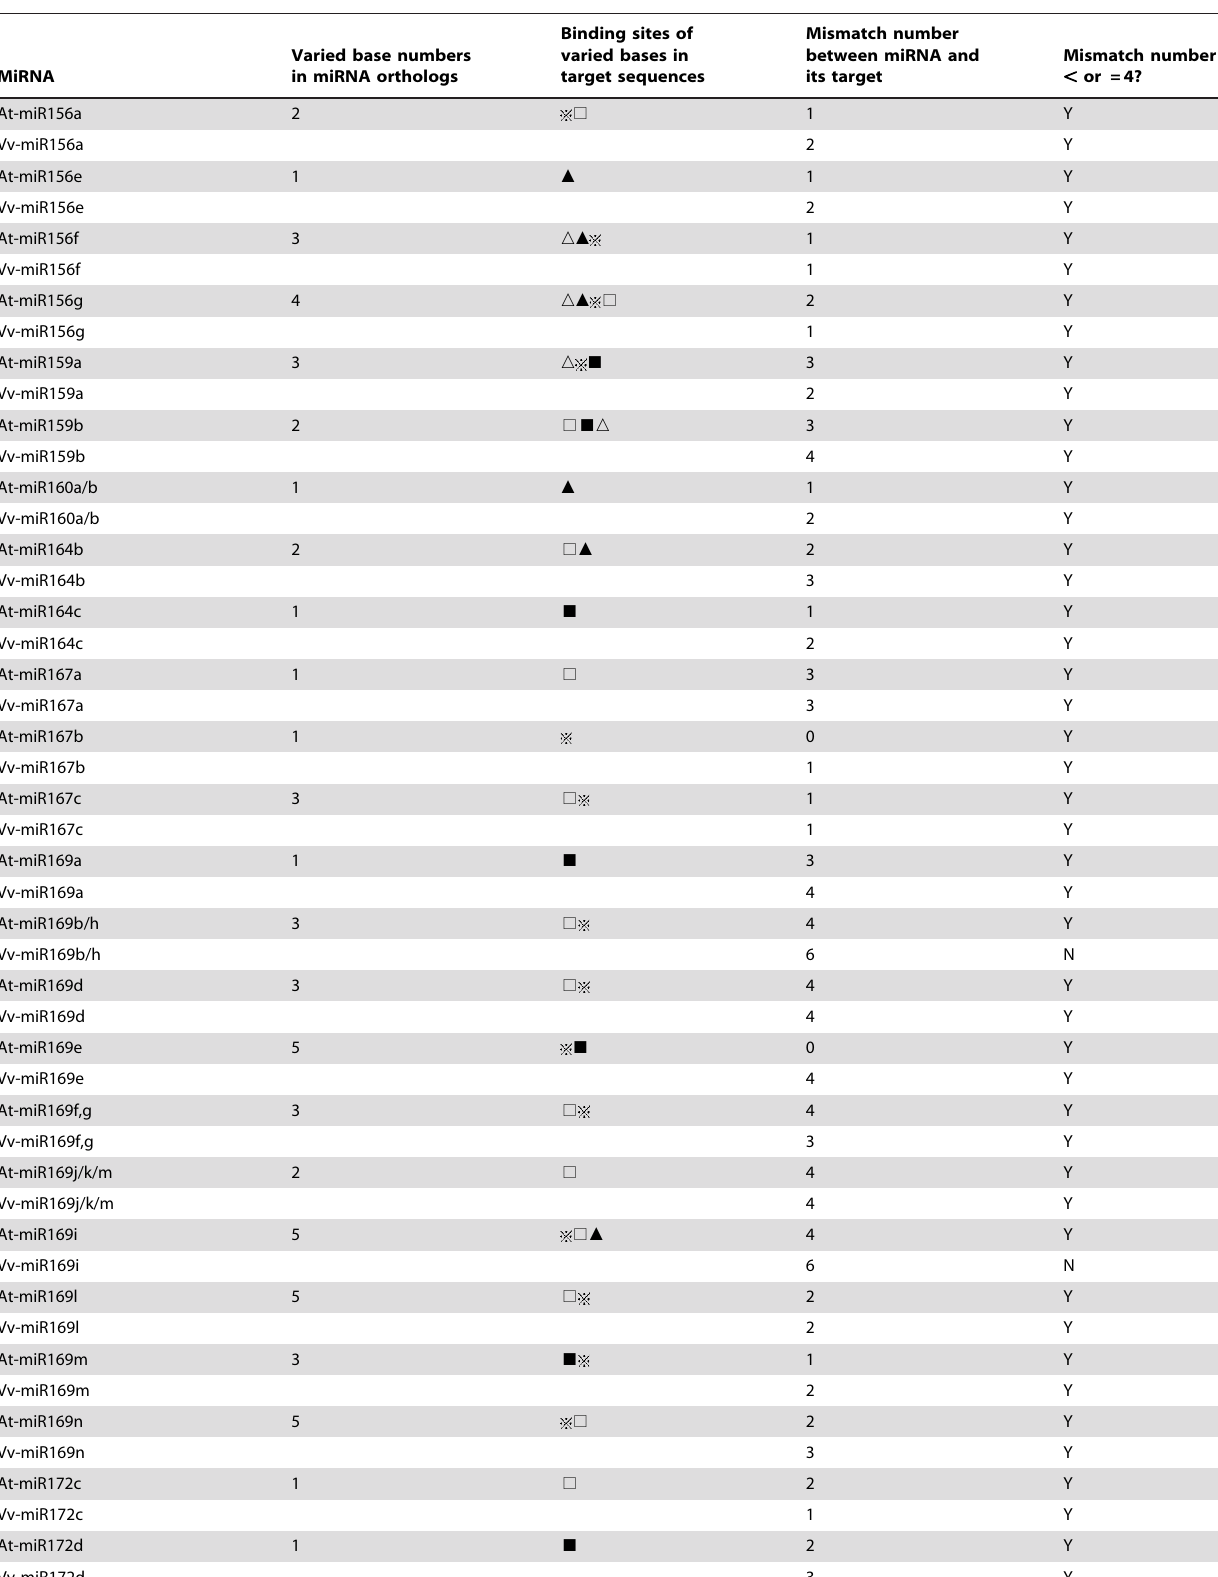
Table 3. Comparison of varied bases of orthologous miRNAs in grapevine and Arabidopsis and binding sites of them.